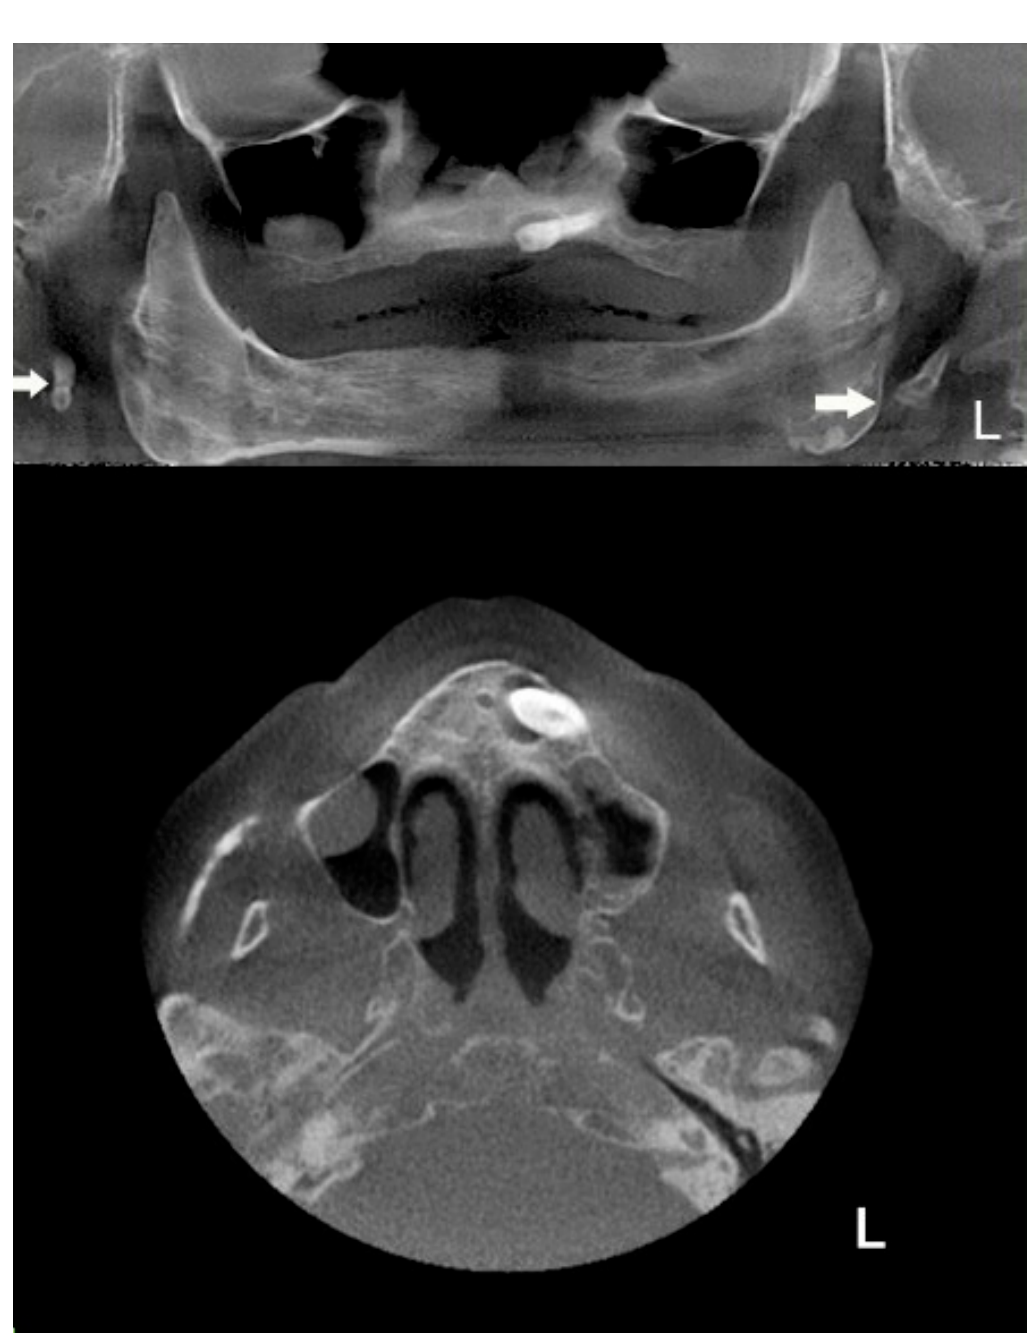
Figure 4. The axial cone beam computed tomography (CBCT) slice shows ( upper image ): panoramic radiography showing an unerupted maxillary left canine with a cyst-like formation around the canine crown and sinus pathology in the right maxillary sinuses. Elongated bilateral stylohyoid complex (SHC) processes are present and attain over one third of the mandibular ramus length (white arrows); ( lower image ): CBCT reconstruction images showing chronic inflammatory hyperplastic mucosa in the left maxillary sinus, impacted canine, while the right maxillary sinus exhibits a mucocele affecting the latero-basal portion of the sinus.